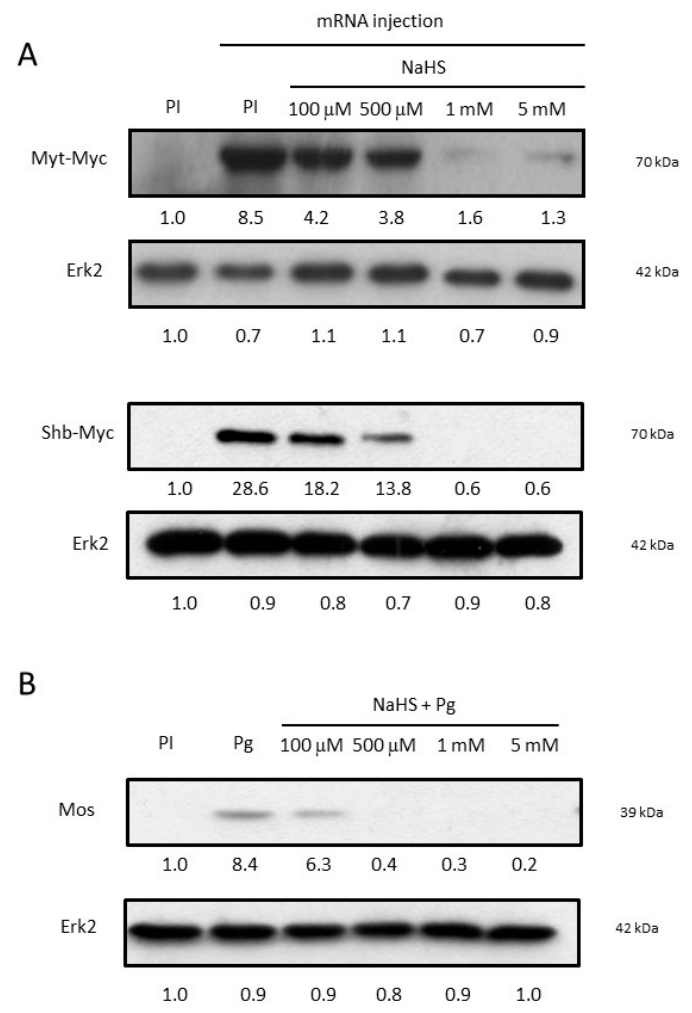
Figure 4. NaHS prevents protein synthesis. ( A ) Western blot of Myt-Myc and Shb-Myc tagged proteins, and Erk2 from immature oocytes (PI) or oocytes micro-injected with mRNA coding for a Myc tagged proteins after pre-incubation or not for 15 min in NaHS at different concentrations. ( B ) Western blot of endogenous Mos and Erk2 from ten pooled oocytes 15 h after NaHS treatments and progesterone induction (4 μ g/mL). Relative intensity of Myc and Mos bands were normalized with the intensity of their respective loading control bands of Erk2. Myc, Mos, and Erk2 band intensity were estimated using Image J software.